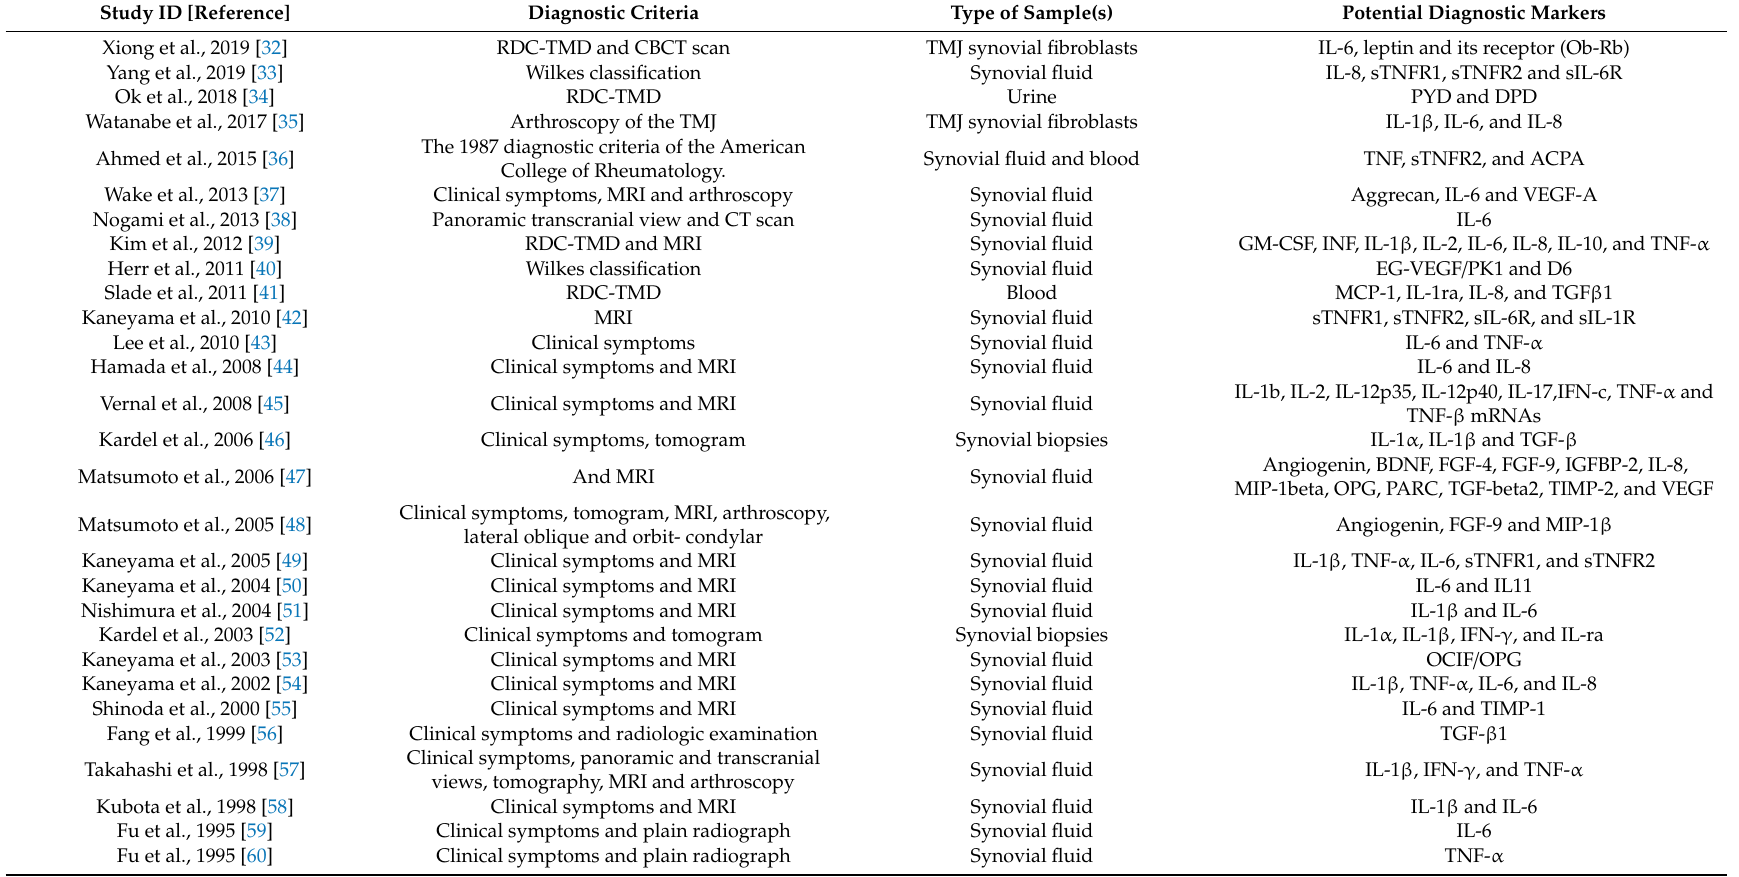
Table 1. List of studies investigated the potential diagnostic markers in patients with